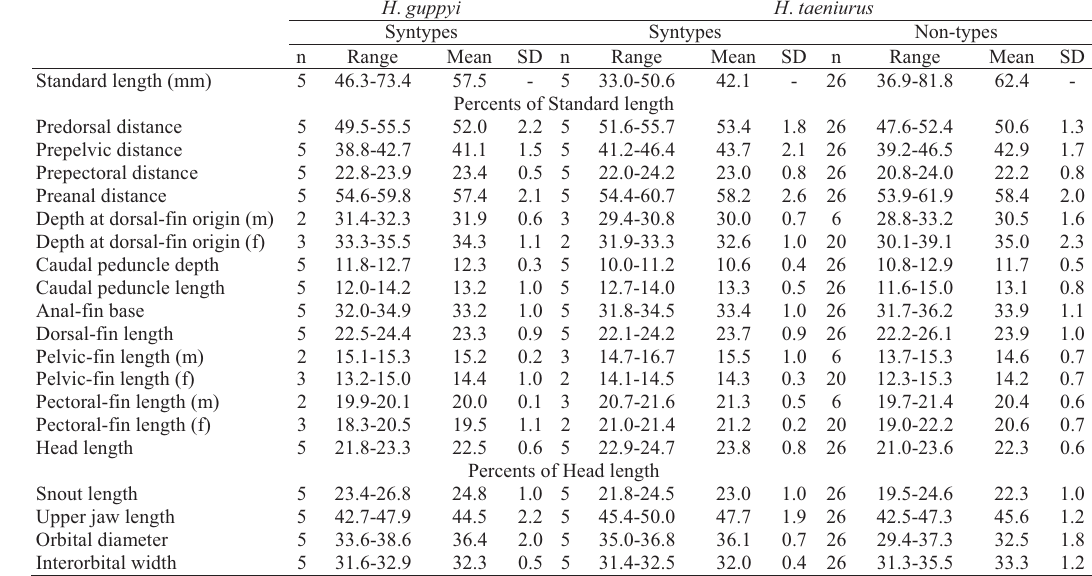
Table 7. Morphometric data of syntypes of Hemibrycon guppyi (= H . taeniurus , BMNH 1906.6.23.13-17), and syntypes of H . taeniurus (ZMUC 962-963, ZMUC 966-968), and non- types of H . taeniurus (AMNH 215239, 215301; INHS 40083; MCNG 8199; ROM 61651; USNM 290408, 290413) from Island of Trinidad, Trinidad and Tobago. m, males; f, females. SD = Standard